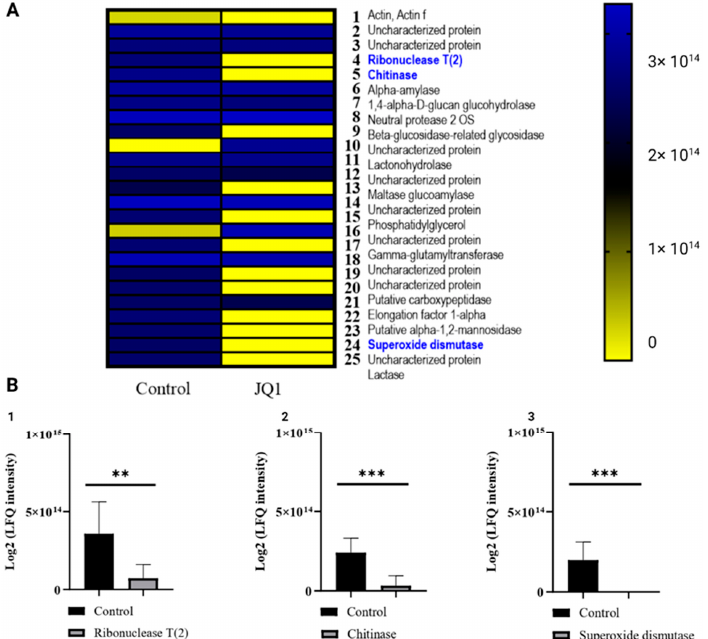
Figure 5. LC-MS/MS results of proteins secreted by A. fumigatus DSM 790 growth with JQ1 or not. ( A ) Extracellular proteins with significantly different abundance after JQ1 treatment. ( B ) Log2 (LFQ intensity) of extracellular proteins ribonuclease (1), chitinase (2), and superoxide dismutase (3) after treatment with JQ1. The values are expressed as mean of at least three biological replicates. Unpaired Student t-tests to statistical analysis were performed. ** p < 0.01, *** p < 0.001 compared to control.